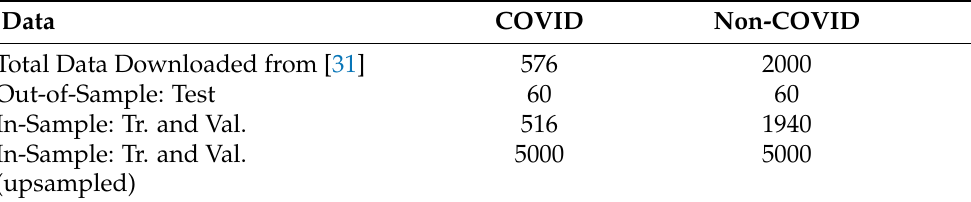
Table 8. The dimensions of the data. We downloadeed the COVID data from Minaee et al. [31]. This totalled 576 COVID images and 2000 non-COVID images. First, we split the test set from the total images. The test consisted of 60 COVID cases and 60 non-COVID cases. Then, we were left with 516 images for the COVID class and 1940 images for the non-COVID class. This was our in- sample set, which we used for training and validating (Tr. and Val., respectively). For the in-sample set, we upsampled the images by adding noise drawn from normal distribution. This produced 5000 COVID images and 5000 non-COVID images for training and testing. The out-of-sample test set had 120 observations, which wre only used in the end to verify the learning performance.